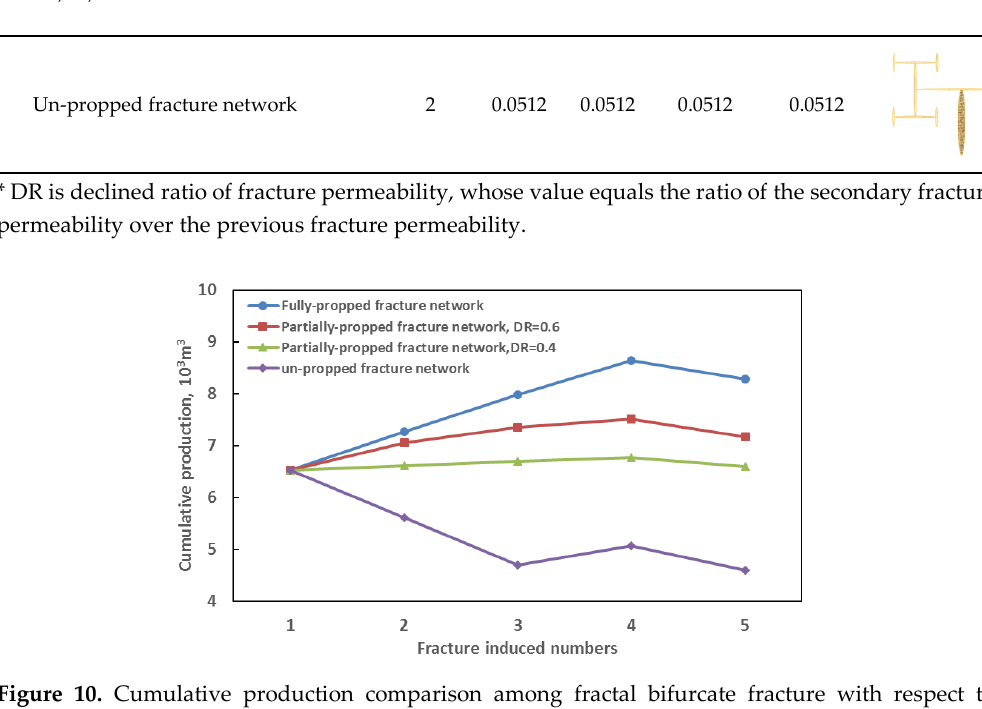
Figure 10. Cumulative production comparison among fractal bifurcate fracture with respect to different fracture network conductivity.